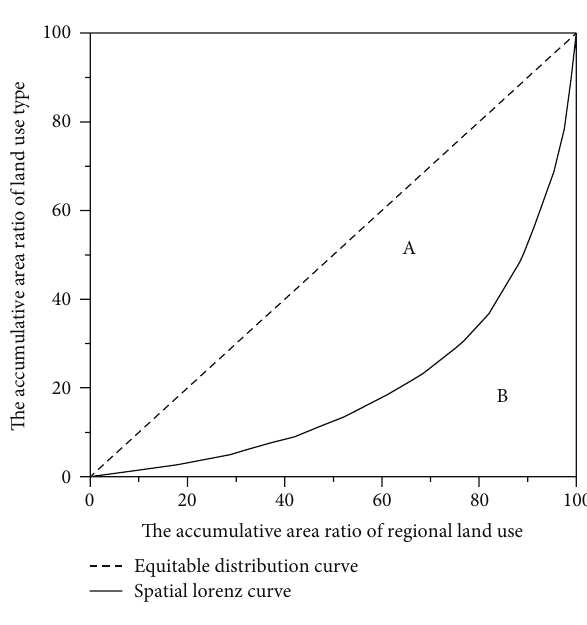
Figure 3: Spatial Lorenz